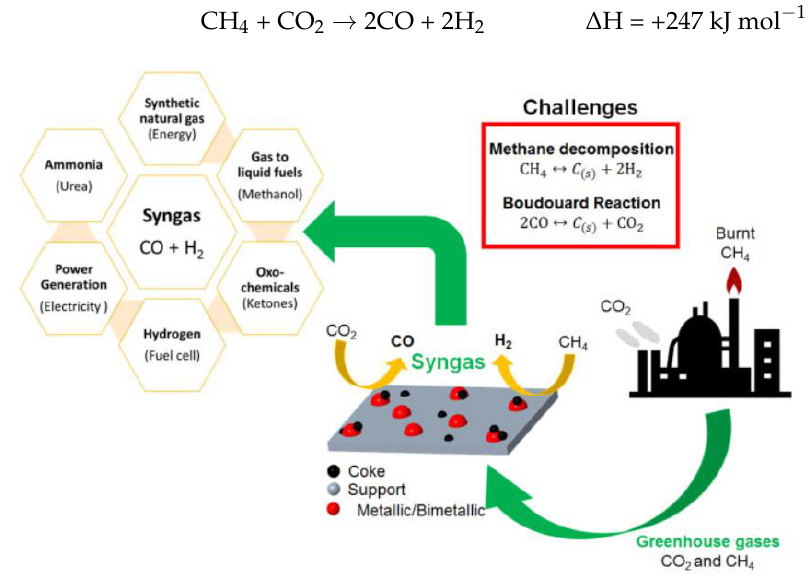
Figure 3. Schematics of the DRM reaction and of syngas utilization. Reprinted from [44].